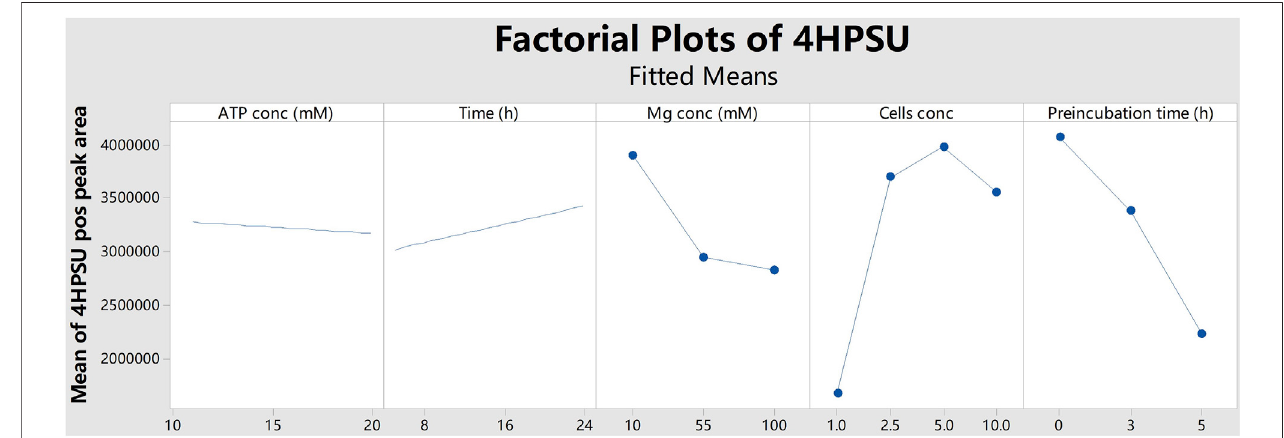
FIGURE 1 | Factorial plots of 4HPSU production with different ATP concentrations (ATP conc), reaction times (Time), MgCl 2 concentrations (Mg conc), cells concentrations (Cells conc), and preincubation times (Preincubation time). The peak areas of 4HPSU were obtained in positive ion mode and mean values were calculated by Minitab.